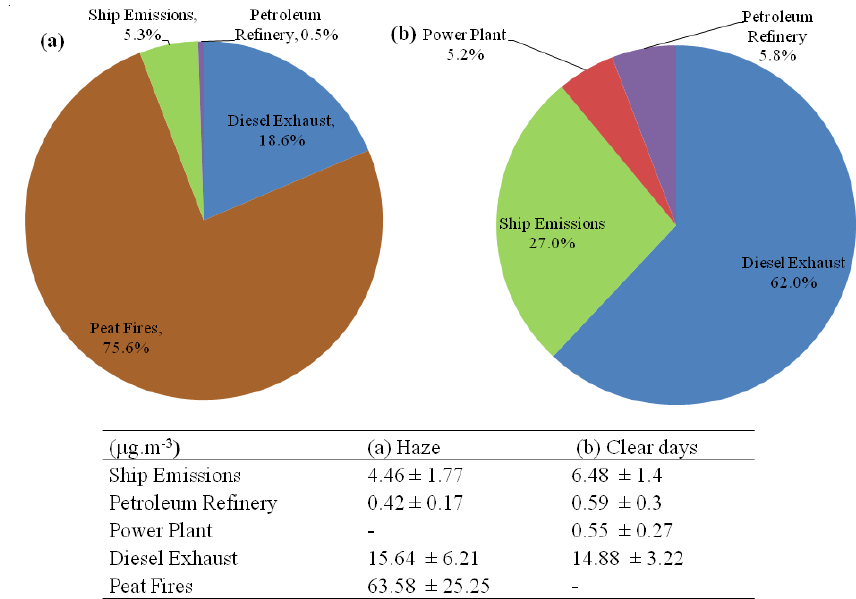
Figure 4. Source contributions to TSP during haze (a) and clear days (b) at St. John’s Island in